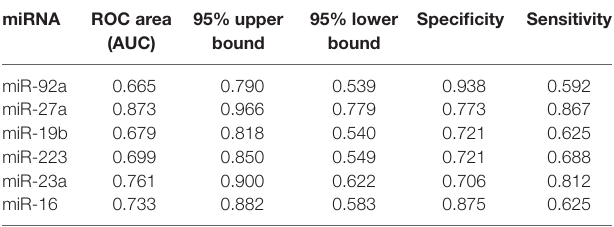
TaBle 5 | Receiver operating characteristic (ROC) curve (AUC) for six microRNAs (miRNAs) in discriminating systemic lupus erythematosus patients from rheumatoid arthritis patients.